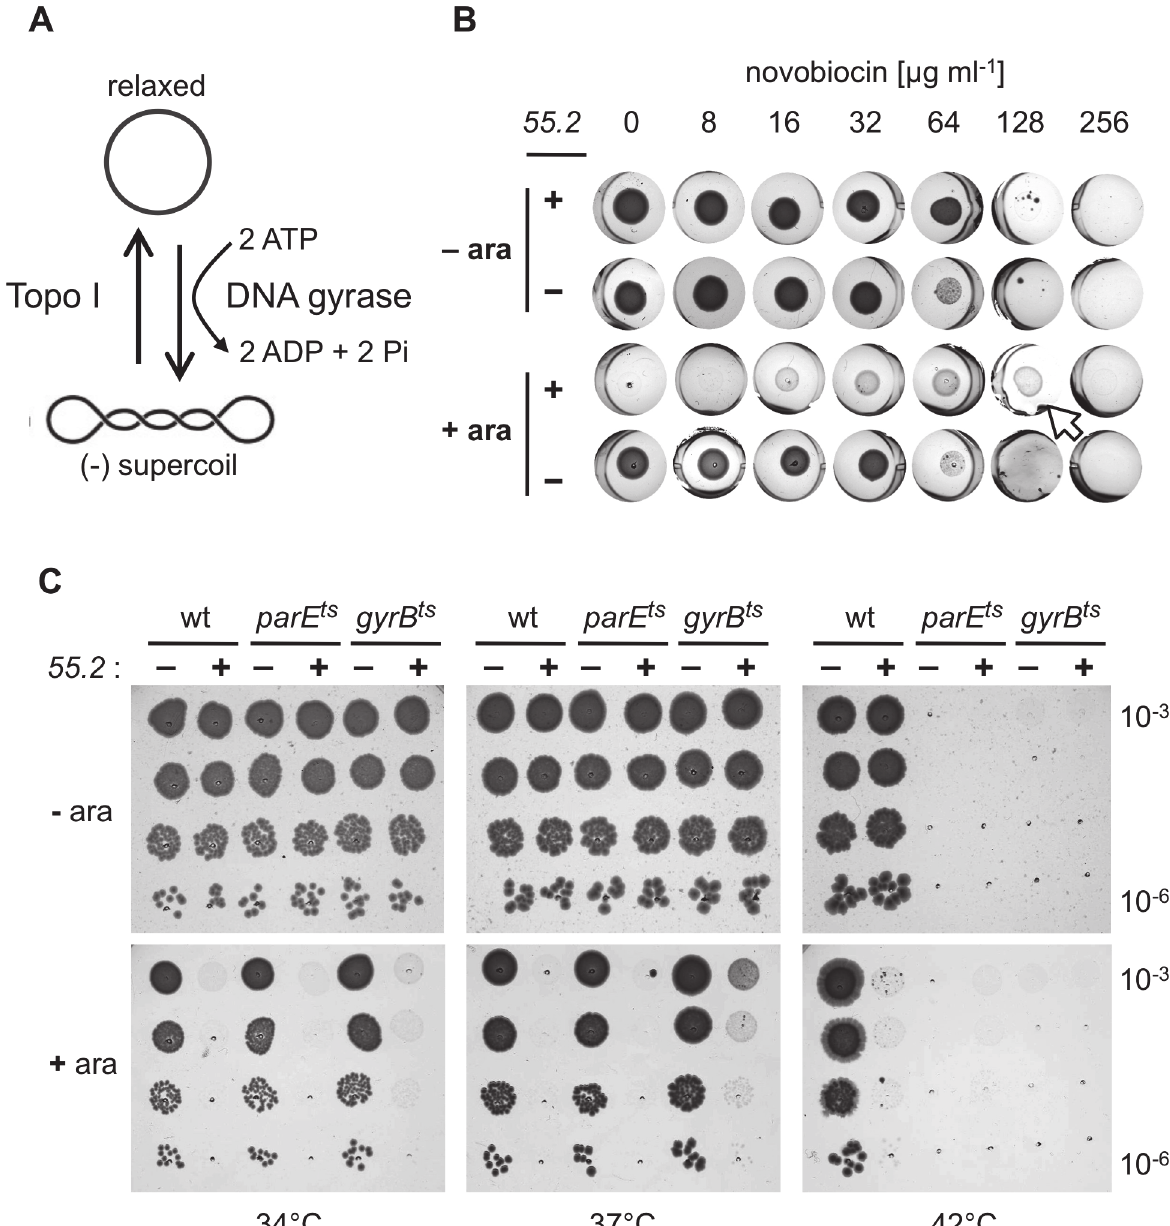
Fig 2. Partial inhibition of DNA gyrase ATPase activity protects from 55 . 2 -induced toxicity. (A) Outline of the regulation of the steady-state level of DNA supercoiling by the opposite actions of DNA gyrase and Topo I. (B) Novobiocin sensitivity assay. Overnight cultures of DB503 bacteria transformed with pBAD101 ( 55 . 2 – ) or pDB2114-101 ( 55 . 2 + ) were spotted on 24 wells LB agar plates with and without 0.2% arabinose containing the indicated amounts of novobiocin, and incubated overnight at 37°C. (C) W3110 (wt), CL001 ( parE ts ), and BP199 ( gyrB ts ) were transformed with pBAD101 ( 55 . 2 – ) or pDB2114-101 ( 55 . 2 + ). Dilution of overnight cultures were spotted on LB agar plates with and without 0.2% arabinose and incubated overnight at the indicated